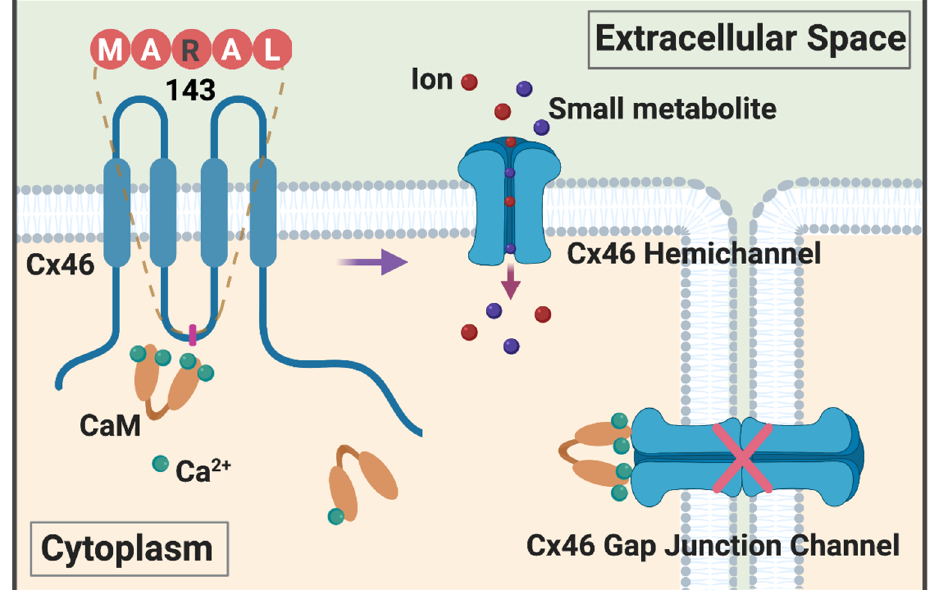
Figure 1. Illustration of molecular mechanisms of Ca 2 + -CaM regulation of Cx46 channel activity. The G143R mutation at the Cx46 intracellular domain alters its secondary structure, resulting in an increased interaction between Cx46 and the Ca 2 + -CaM complex, inducing a reduction of gap junction conductance and a decrease of sensitivity to Ca 2 + and pH. At the same time, enhanced association of Cx46 with CaM decreases Cx46 hemichannel voltage sensitivity, but increases hemichannel permeability to small molecules. The presence of leaky hemichannels and lack of electrical and metabolic coupling is not compatible with lens fiber homeostasis, leading to cataract formation.